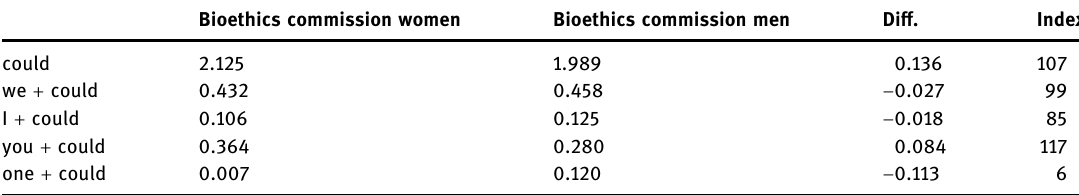
Table 24: “ Could ” collocations with preceding pronouns, as per cent of total tokens ( normalised, n = 1,000 )